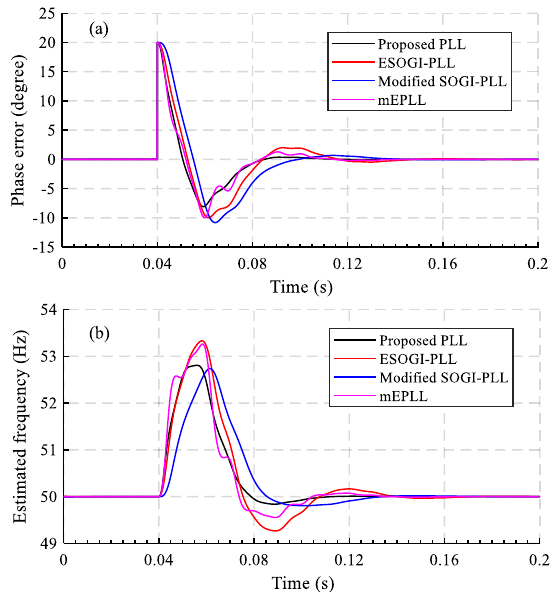
Fig. 9 Performance comparison between the proposed PLL, ESOGI-PLL, modified SOGI-PLL, and mEPLL under Case 3 (a frequency jump by 3 Hz at 0.04 s). a Estimated phase error and b estimated grid frequency